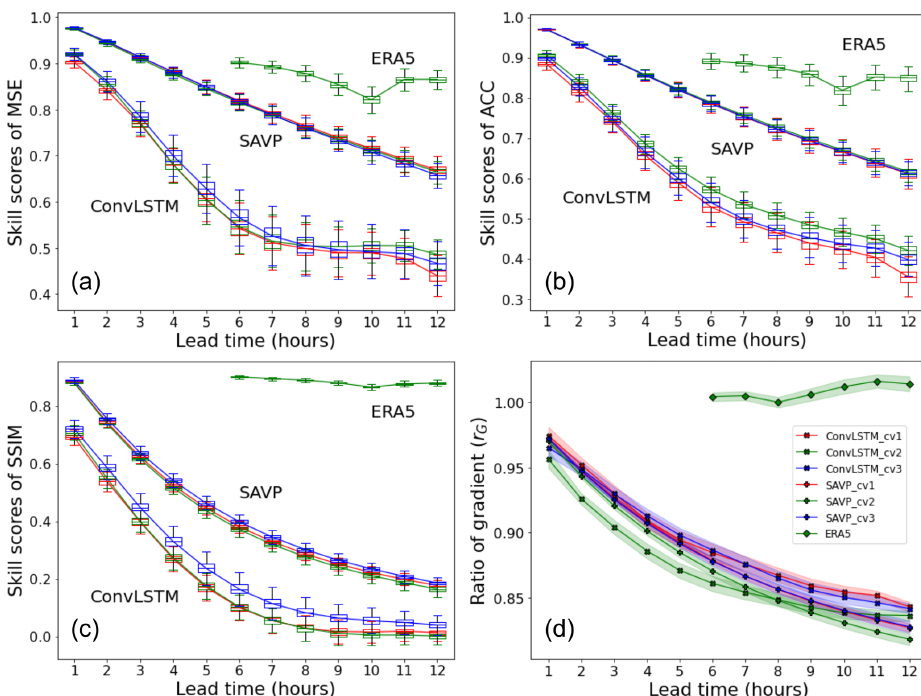
Figure 5. Averaged skill scores of (a) MSE, (b) ACC, and (c) SSIM across lead time ( x axis) for the SAVP and the ConvLSTM models as well as ERA5 short-range forecasts. Both video prediction models are trained with the three cross-validation datasets (with CV 1–3 in D1) displayed in Fig. 2. The testing period of the ERA5 short-range forecasts covers the year 2019, which corresponds to CV 2. The persistence serves as the reference forecast. Sampling uncertainty estimated via block bootstrapping is illustrated by box-and-whisker plot showing the inter-quartile and inter-decile ranges of the skill score values. Panel (d) shows the ratio of the spatially averaged 2m temperature gradient for the same video prediction models and ERA5 short-range forecasts. The persistence forecasts (not shown) attain a constant value of r G = 1 since local spatial variability is